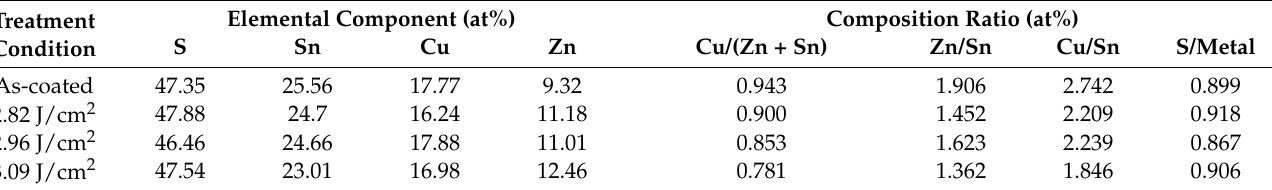
Figure 7. A J – V curve of the photo-sintered CZTS thin film solar cell. Table 3. The measured performance of the photo-sintered CZTS thin film solar cell with CdS and ZnS buffer layers. Condition